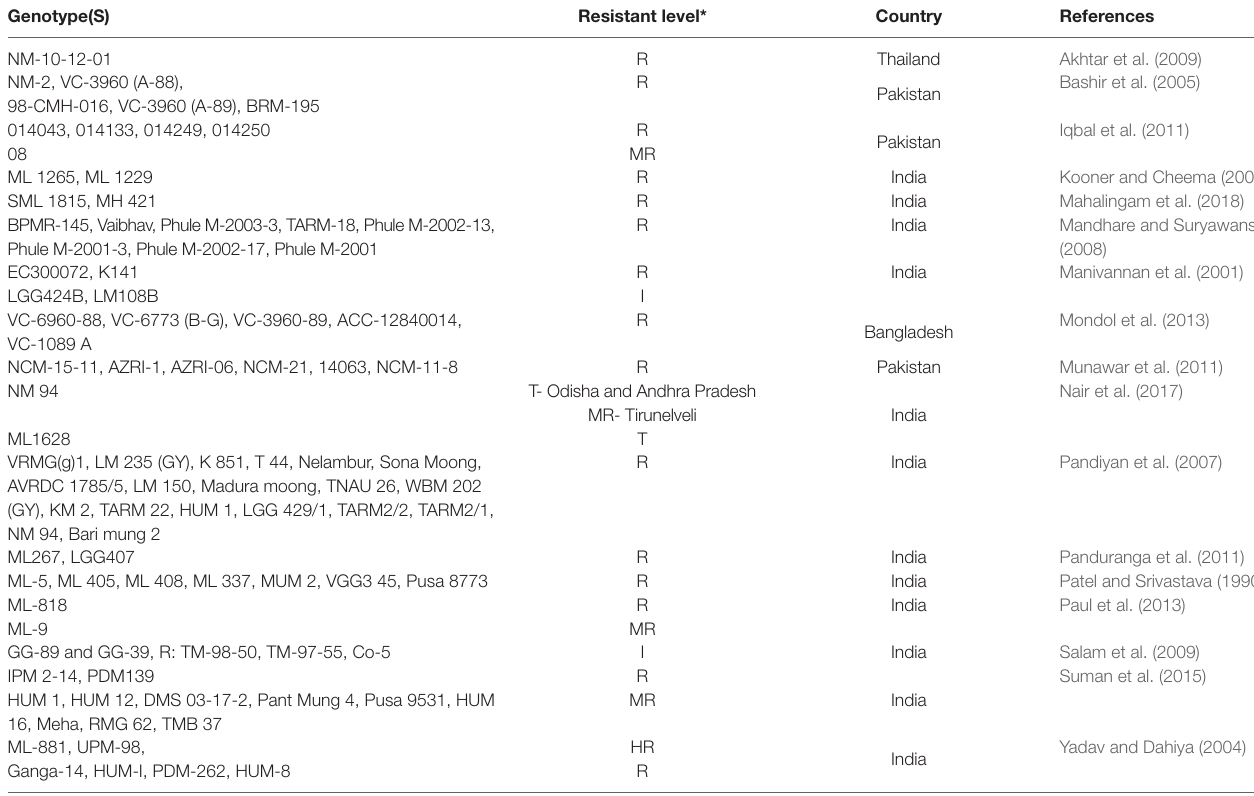
TABLE 1 | Resistant sources of mungbean against mungbean yellow mosaic